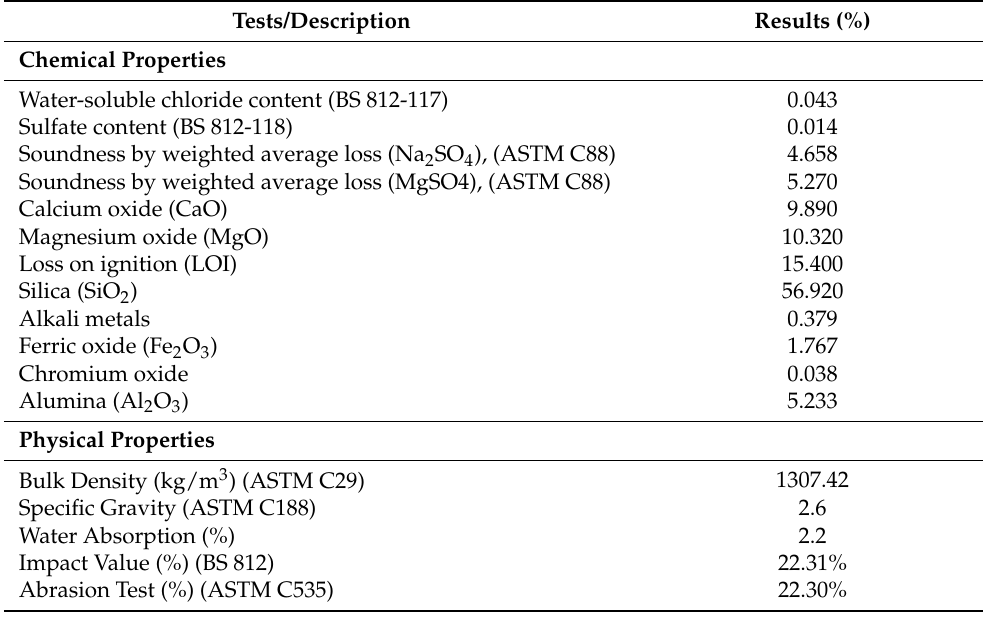
Table 4. Chemical and physical properties of aggregates used in mixtures.